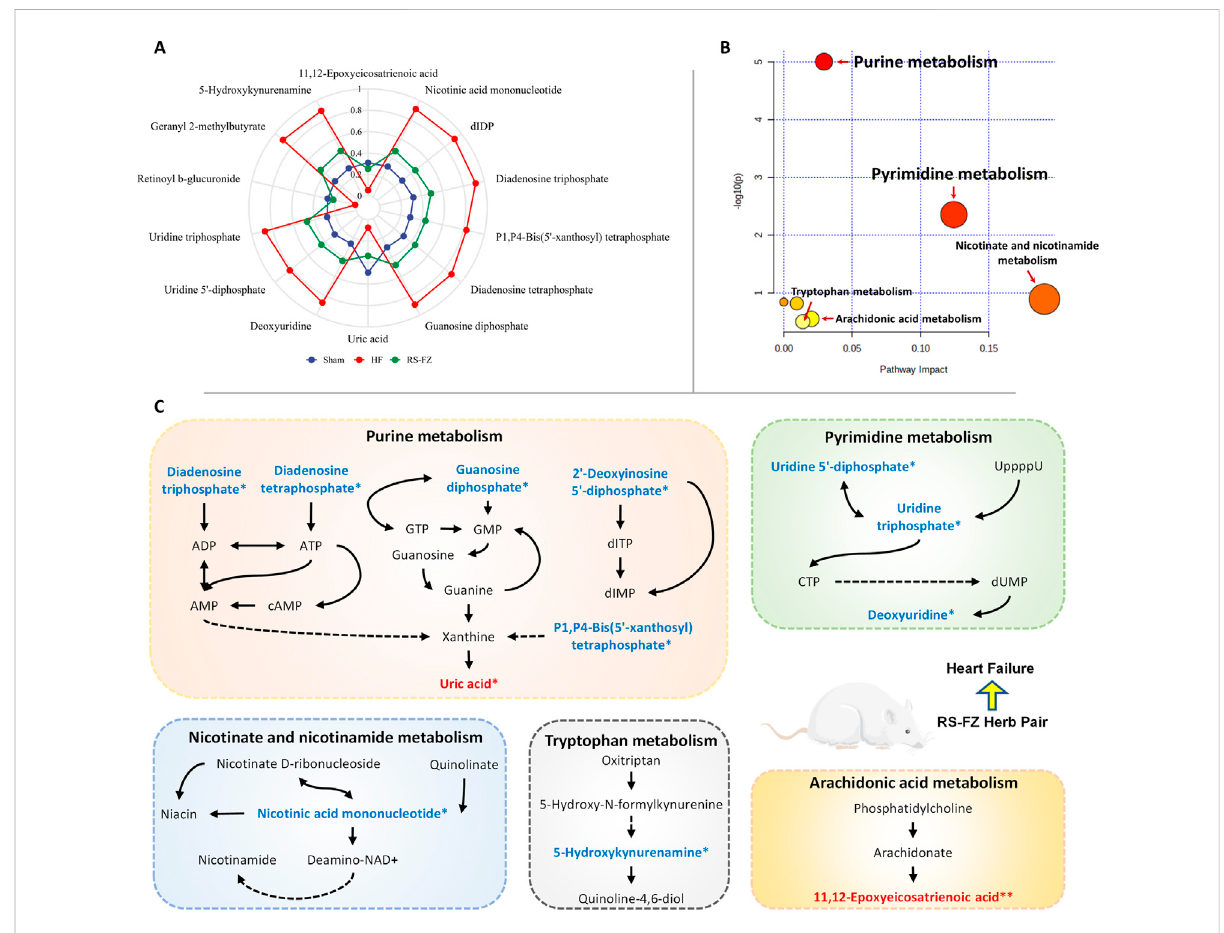
FIGURE 5 Overall metabolic pro fi le (A) Radar chart of relative abundance of 14 speci fi c metabolites (B) Metabolic pathways as visualized using MetaboAnalyst (C) Representative metabolic pathwaysdemonstrated inmetabonomics analysis, bluerepresents metabolitesdownregulated byRS- FZ whereas red represents metabolites up-regulated by